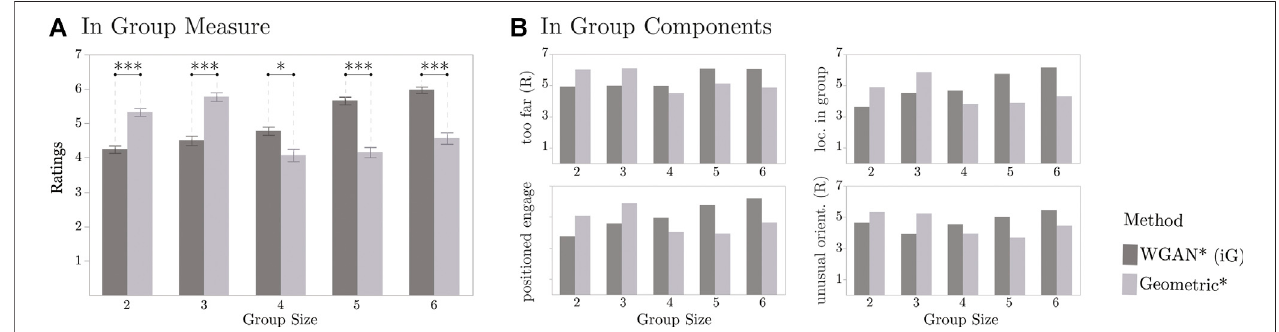
FIGURE9| ResultsfromonlinehumanevaluationcomparingtheGeometricanddata-drivenapproach(WGAN).Intheleftplot,thesymbol*indicates p < 0.05and *** indicates p < 0.001, and error bars correspond to standard. error. The right plots only show averages to illustrate the similarity among